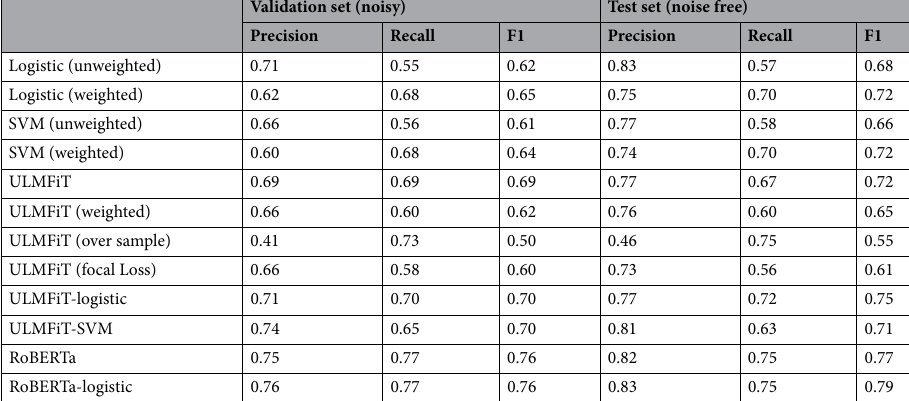
Table 2. Out-of-sample classification performance. The table provides macro-averaged precision, recall, and F1 score to compare model fit across “shallow” descriptive classifiers and “deep”transfer learning architectures. Logistic (Unweighted) : Logistic regression classifier using TF-IDF weighted features and optimized via grid- search. Logistic (Weighted) : Logistic regression classifier using TF-IDF weighted features, weighting for class imbalance, and optimized via grid-search. SVM (Unweighted) : A linear support vector machine classifier using TF-IDF weighted features and optimized via grid-search. SVM (Weighted) : A linear support vector machine classifier using TF-IDF weighted features, weighting for class imbalance, and optimized via grid-search. ULMFiT models: We start with a pre-trained language model which utilizes the Wiki-103 corpus. We then tuned the pre-trained model using 1) our training set ( n = 23, 436 ) and a large, random sample ( n = 100, 000 ) of unannotated blog and CTT paragraphs. Second, we trained the classification model using the training and validation sets described above. Given observed class imbalances, we examined four variations of the